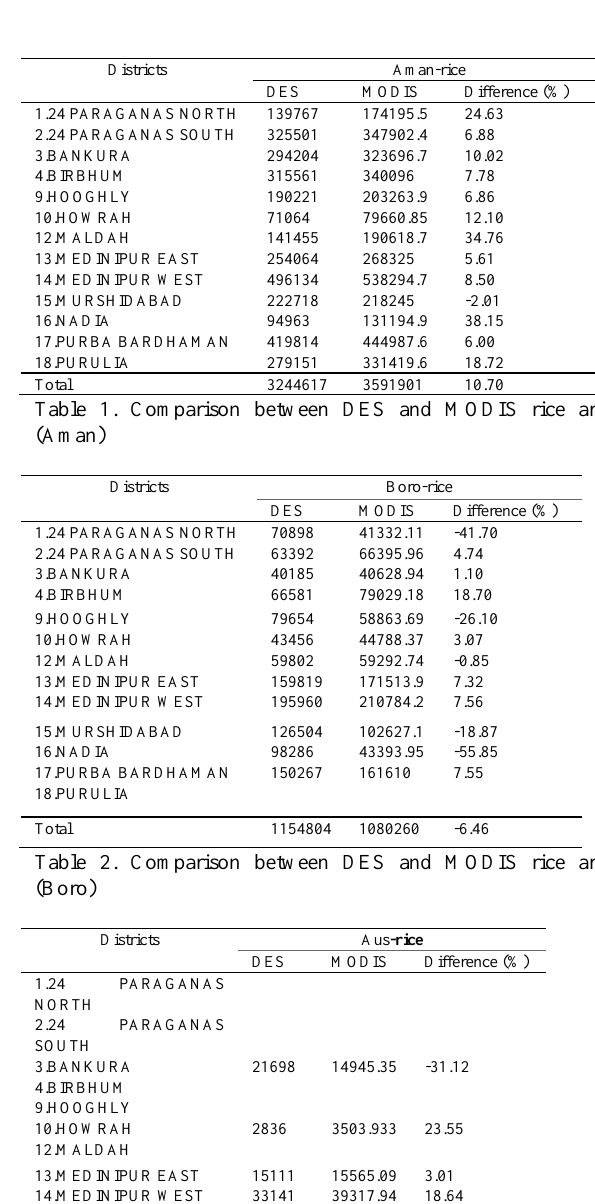
Figure 6. Comparison of area statistics between MODIS and